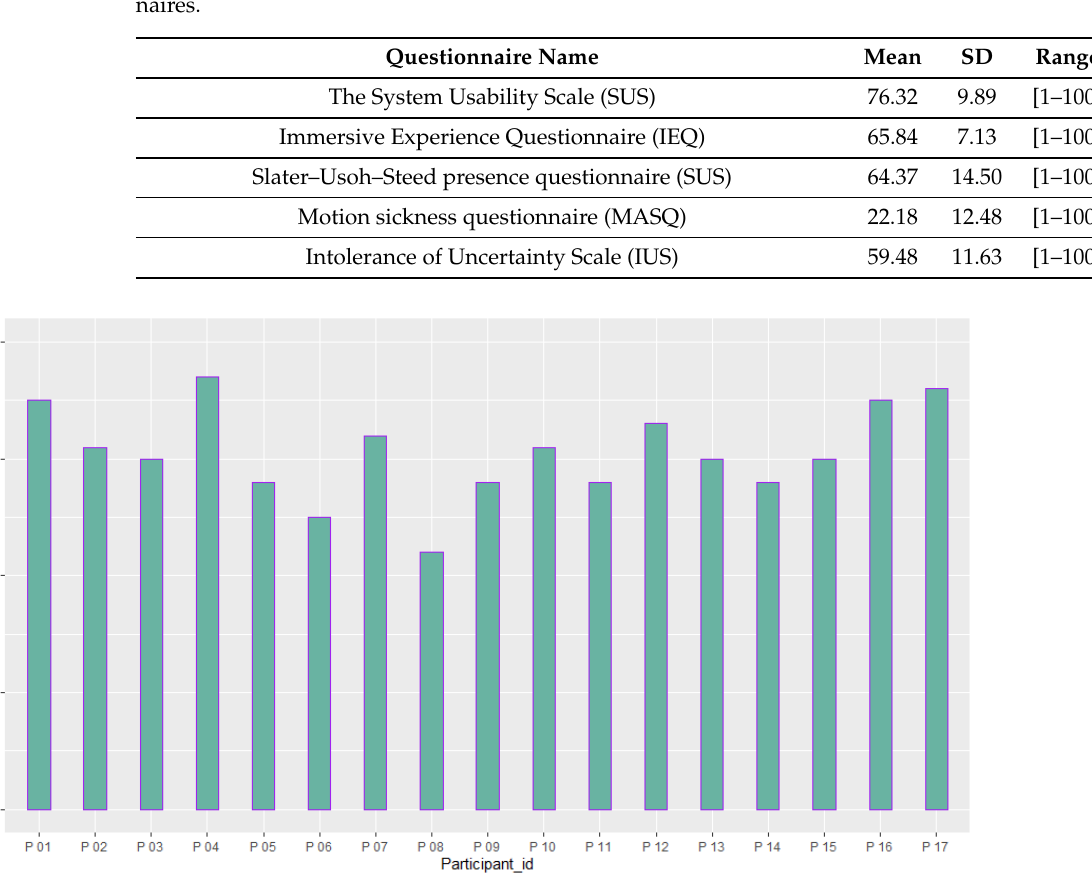
Figure 14. A comparison between the scores obtained from the participants from the System Usability Scale (SUS) questionnaire (M = 76.32, SD =